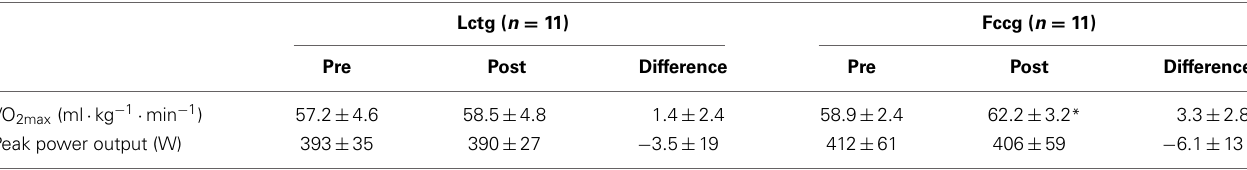
Table 1 | Maximal oxygen consumption (VO 2max ) and peak power output (mean ± SD ) pre and post training intervention period for the low cadence training group (Lctg) and the freely chosen cadence group (Fccg).